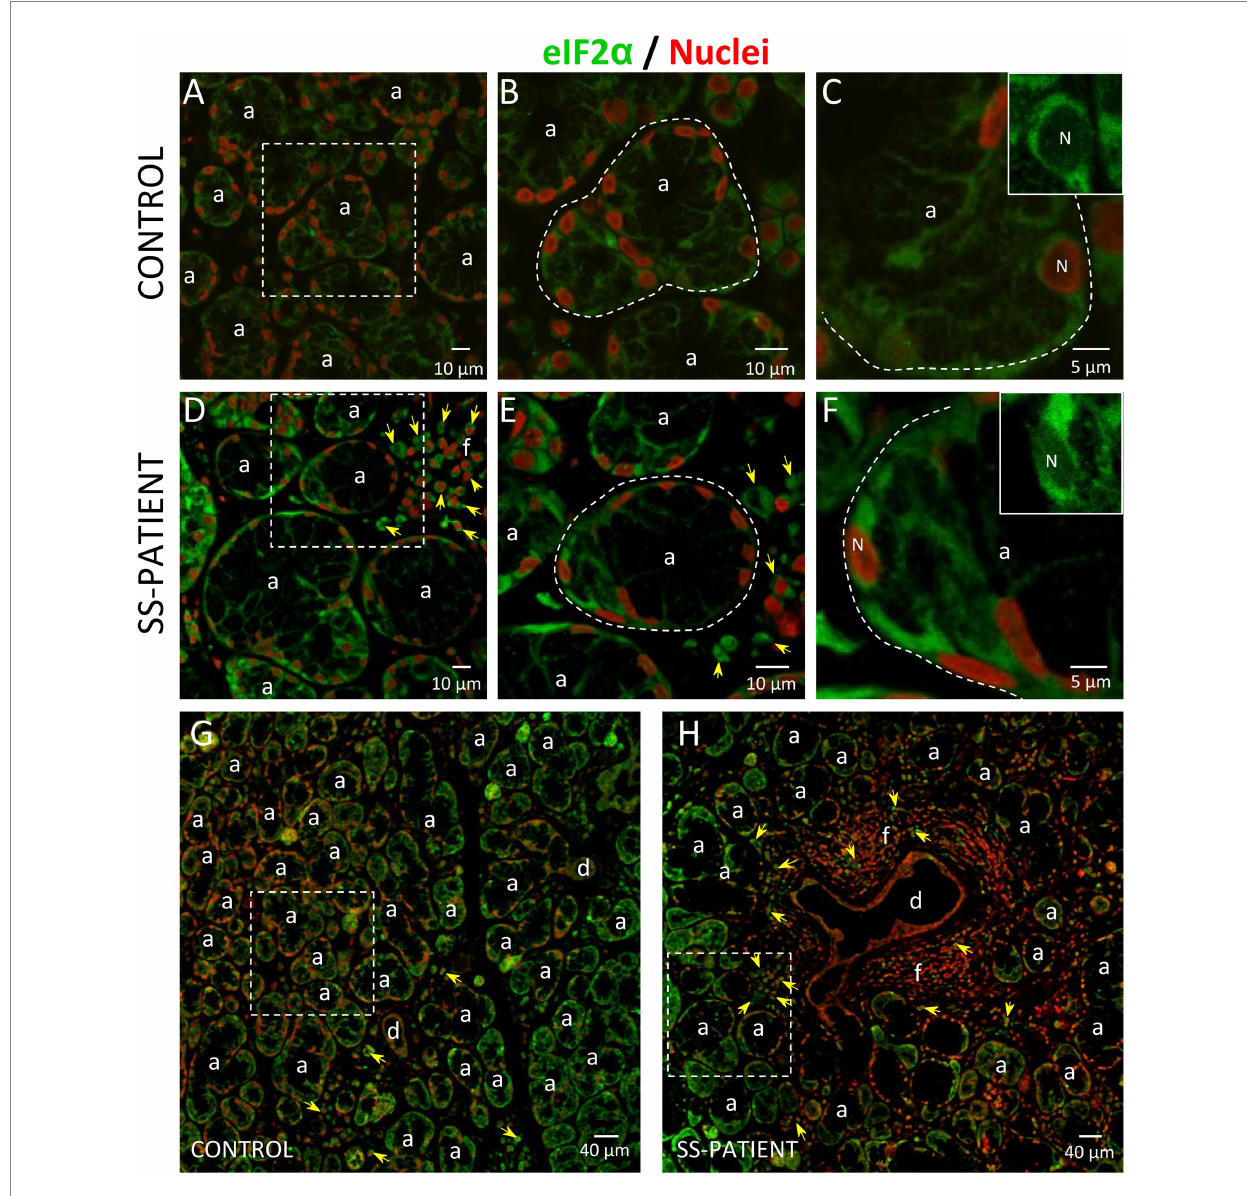
FIGURE 9 Localization of eIF2 α in LSGs from control and SS-patients. (A–C,G) eIF2 α (green) staining was mainly observed in the basolateral cytoplasm of epithelial cells in LSGs from control subjects. (D–F,H) eIF2 α (green) staining was also observed in the basolateral cytoplasm of epithelial cells and plasma cells (yellow arrows) in LSGs from SS-patients. (A,D) Higher magnifications of regions surrounded by broken lines in G and H, respectively. (B,C,E,F) Higher magnifications of regions surrounded by broken lines in A and B, respectively. Nuclei (N, red) were counterstained with Hoechst-33342. a: acini; d: duct; f: focus of inflammatory cells. Bars A, B, D and E: 10 μ m; C and F: 5 μ m; G and H: 40 μ